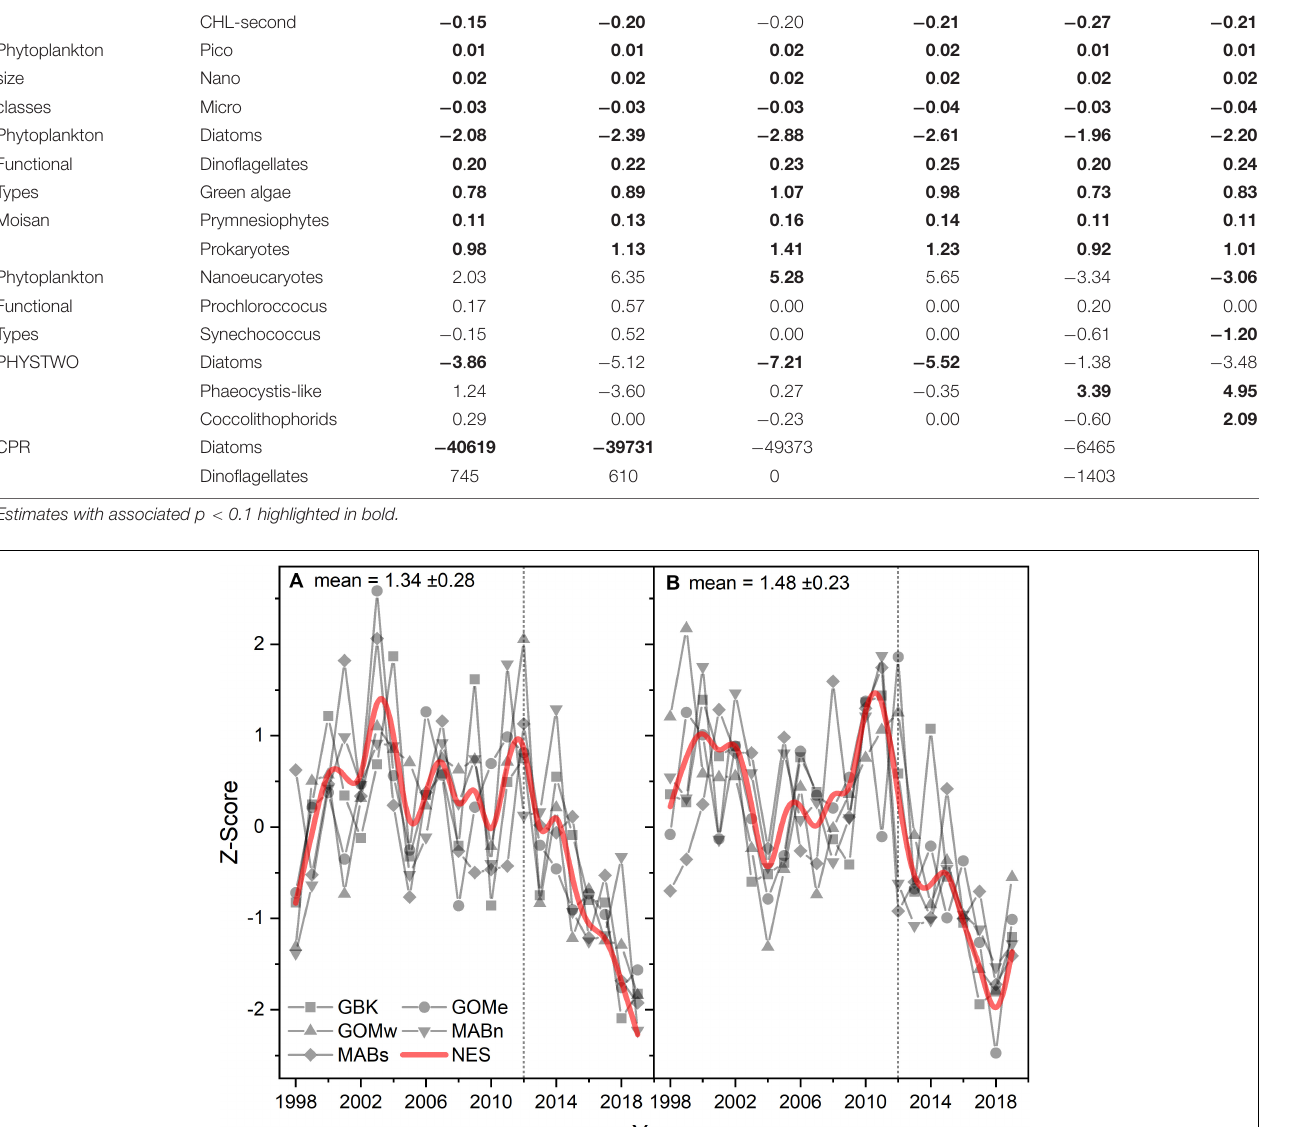
and picoplankton levels after 2012, indicating a population shift away from a eutrophic coastal productive population to a more oligotrophic and less productive population. The